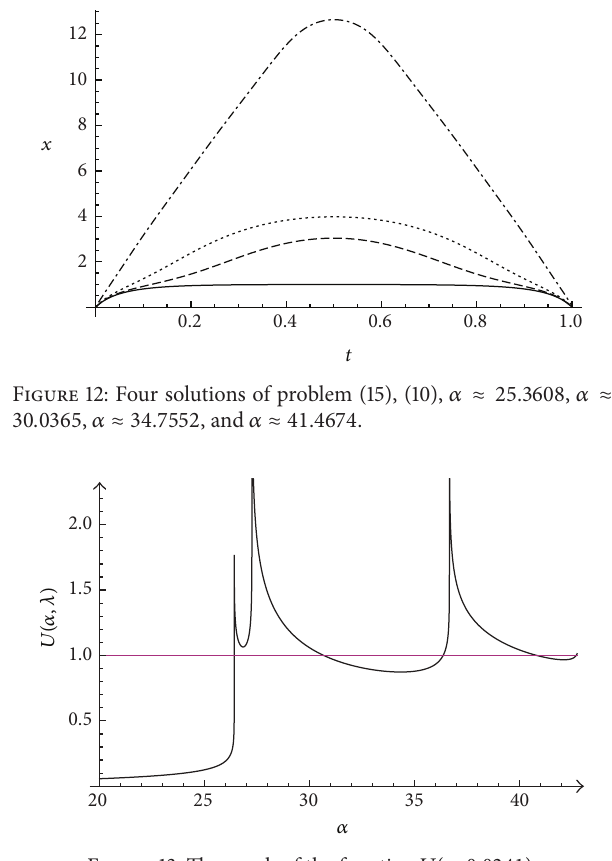
Figure 13: The graph of the function 𝑈(𝛼,0.0241) .